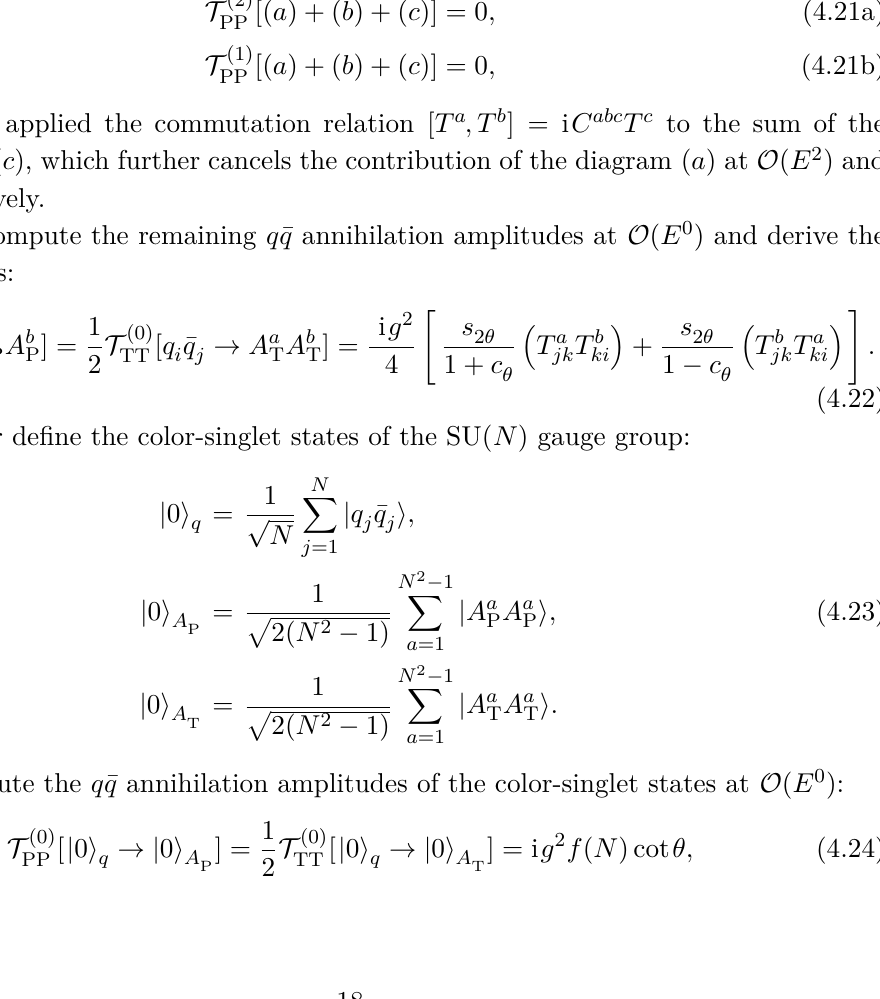
Figure 3 . Scattering processes of quark-antiquark annihilation into two gluons, q ( q ¯ q → A a A b ) in the 3d topologically massive i j T T